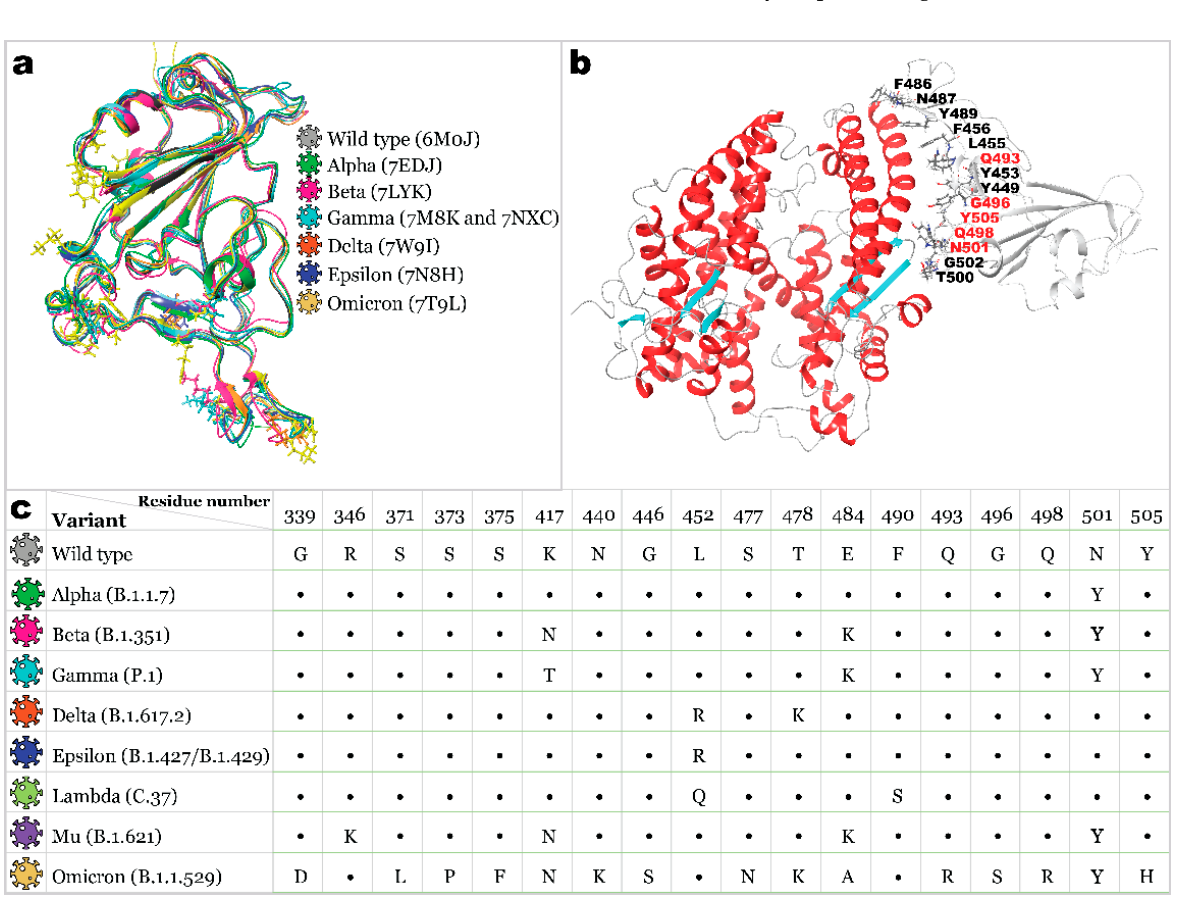
Figure 1. Structures of the SARS-CoV-2 S protein RBD: ( a )—superposition of available RBD 3D structures with the ball-and-stick representation of mutated residues (ribbons and residues colored based on variant); ( b )—wild-type RBD bound to ACE2 (PDB ID: 6M0J) with RBD residues reported to interact with ACE2 being marked, and mutating residues’ labels being colored in red; ( c )—list of occurred mutations for variants studied here.